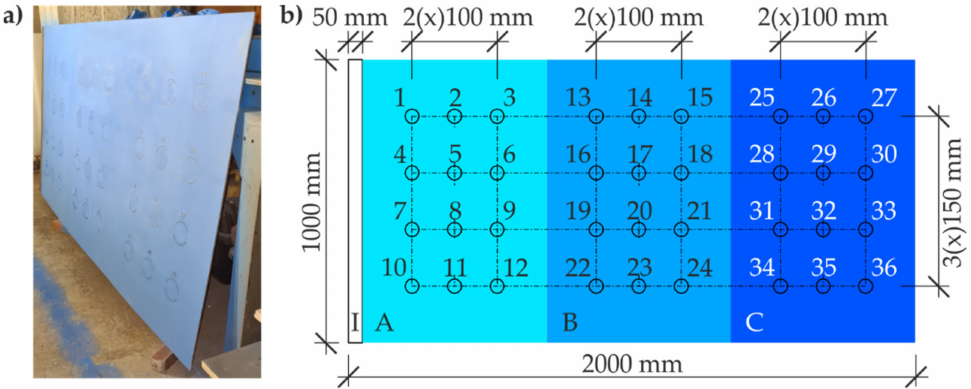
Figure 3. The steel sheet for main tests: ( a ) the sheet before testing; ( b ) the model divided into areas of different thickness of the paint coating and the numbered test